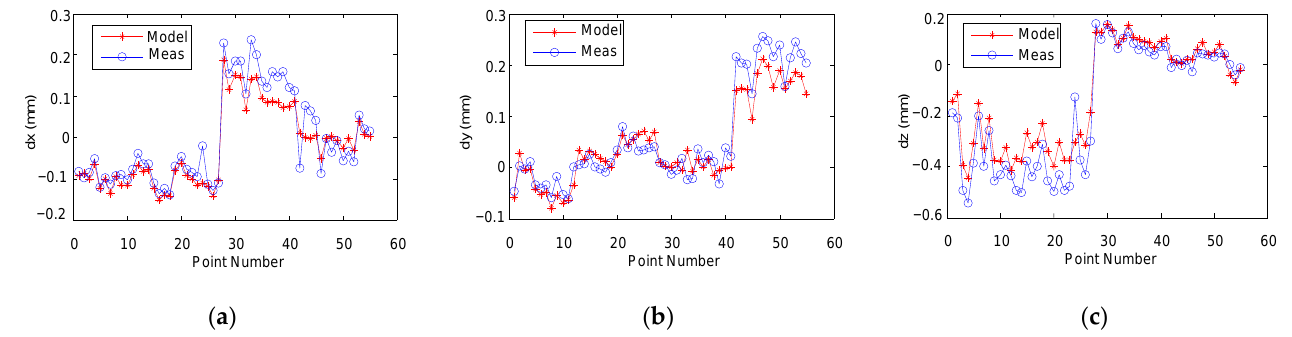
Figure 7. The displacement errors obtained by FPM-CSES and measurements ( a ) along the X-direction; ( b ) along the Y-direction; ( c ) along the Z-direction.